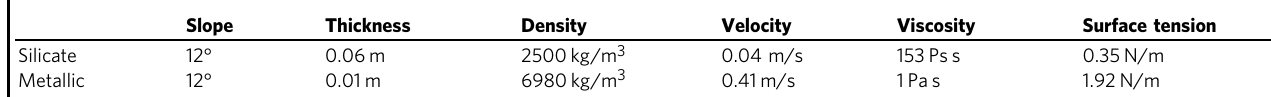
Slope Surface tension